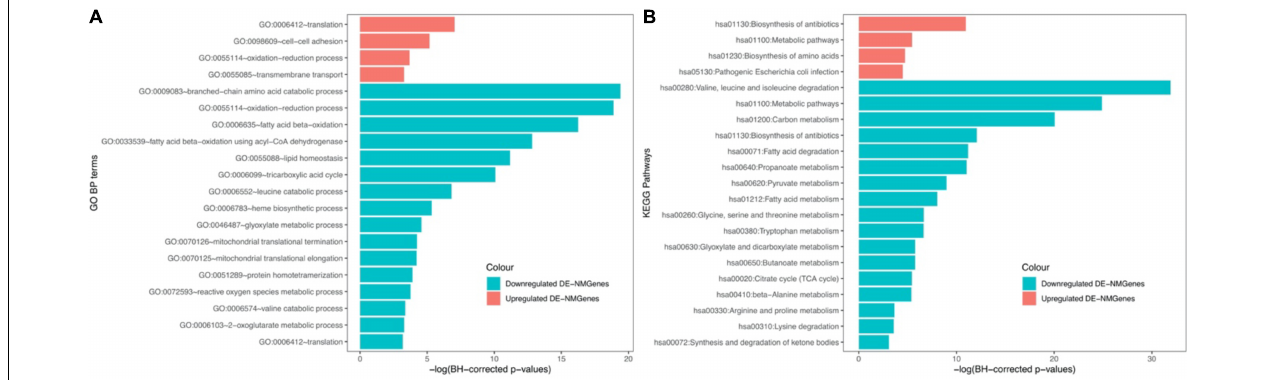
FIGURE 2 | GO and KEGG enrichment results of 141 upregulated DE-NMGenes and 175 downregulated DE-NMGenes. Bar graph of the significantly enriched BP (A) and KEGG (B) . Blue and red bars represent the enriched BP terms or KEGG pathways for upregulated and downregulated DE-NMGenes, respectively.